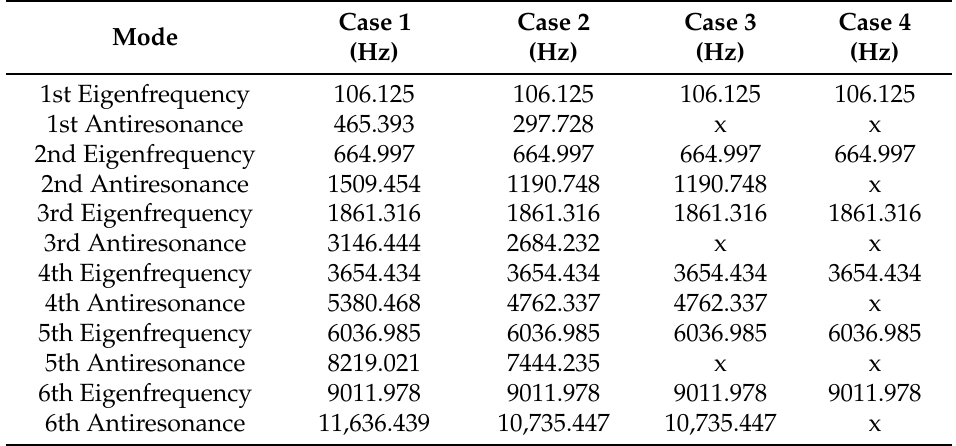
Figure 8. Shape of the whisker beam at the first six modes. Finite element analysis was performed using COMSOL. The first mode is at 106.183 Hz, which is within the fundamental frequency range from 35 Hz for long whiskers to 110 Hz for short whiskers [9]. More importantly, it shows the ability to choose any frequency with given materials, type of bonding and dimensions. Table 3. First six modes of vibration calculated using transfer functions as discussed in Section 2.2.3. Modes are listed in order of their